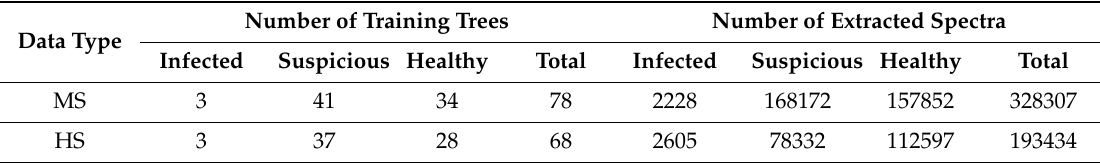
Table 1. Number of trees and corresponding number of points available for training.